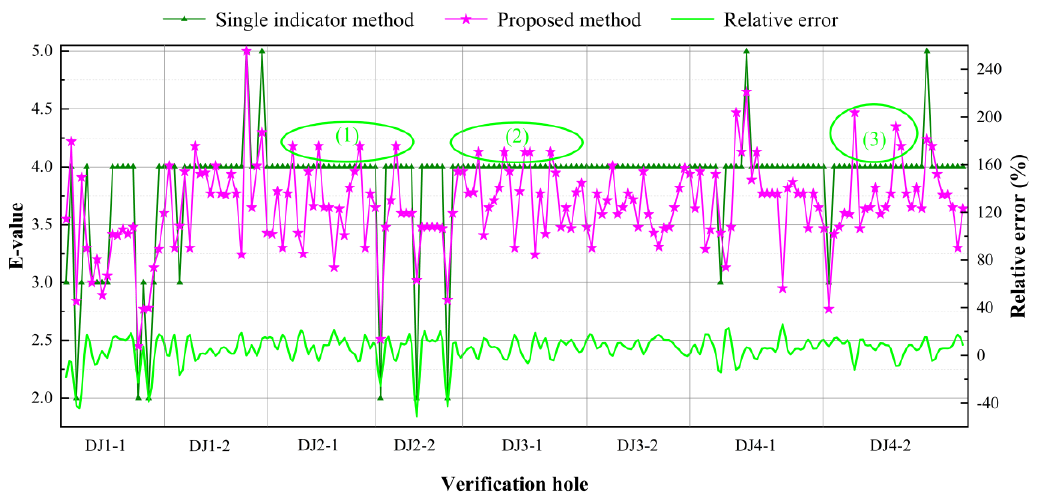
method. Note: The calculation equation of relative error is shown in the Appendix Figure 14. Comparison of the evaluation results by the single-indicator method and the proposed method.